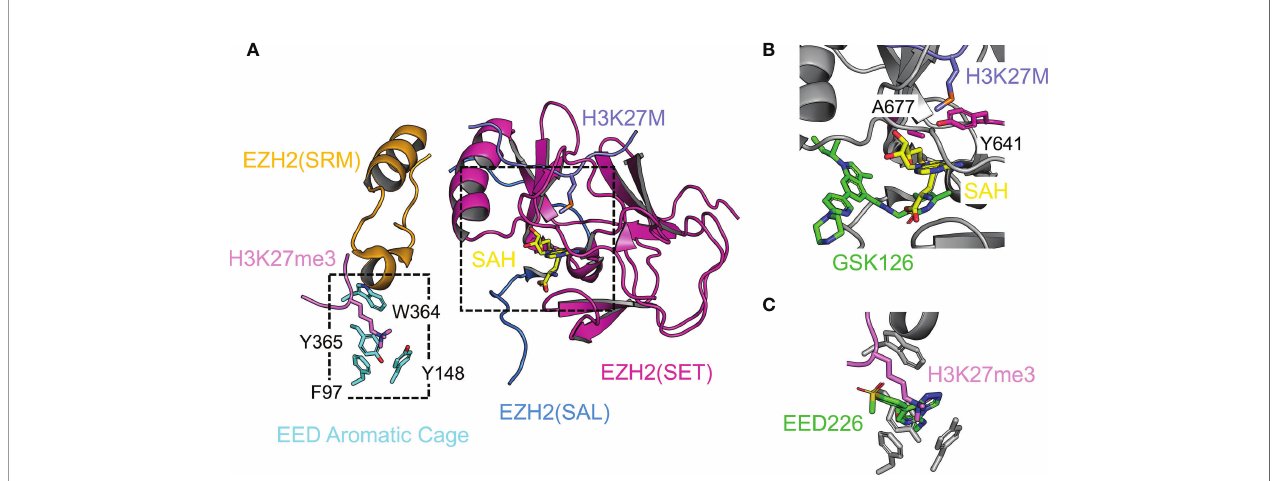
FIGURE 6 | Structural analyses of enzyme catalysis, chemical inhibition, and protein inhibition Enzyme active site is shown. (A) Structure of the catalytic module of PRC2 in the stimulated state (from PDB 5HYN). The split catalytic domain consists of the EZH2(SET) and EZH2(SAL). The EZH2(SRM) bridges the stimulating signal to the EZH2(SET). EED aromatic cage residues are labeled. H3K27M oncohistone occupies the lysine binding channel at the active site. The JARID2K116me3 peptide in the original structure was replaced by the H3K27me3 peptide from PDB 3IIW based on the structural alignment. (B) Close-up view of the active site. SAM-competitive PRC2 inhibitor GSK126 from the aligned crystal structure PDB 5WG6 is represented by green sticks. (C) Close-up view of the EED aromatic cage. The allosteric PRC2 inhibitor EED226 from the aligned crystal structure PDB 5GSA is represented by green